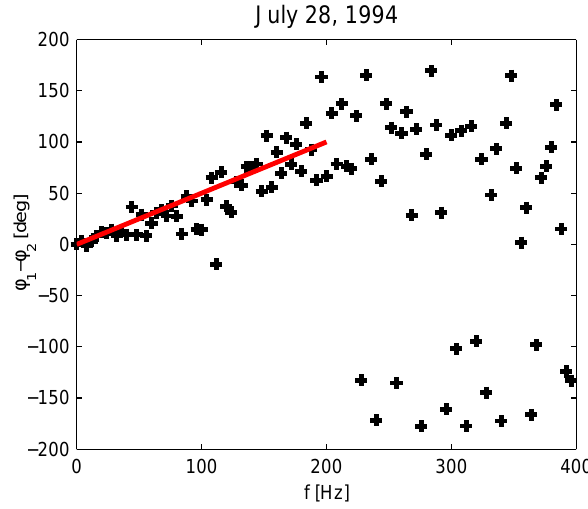
Fig.6. Phasedifferenceversusfrequencyfortwocrosscorrelateddensitysignals. Thephasedifferenceissmall Fig. 6. Phase difference versus frequency for two cross correlated in the zero frequency limit. For low frequencies (long wavelengths) there is a good fit to a straight line, and density signals. The phase difference is small in the zero frequency the estimated phase velocity is just the satellite velocity with respect to Earth. The linear fit is made for data limit. For low frequencies (long wavelengths) there is a good fit withacoherence above0.5. Hence,weconclude thatthedensityvariationsarespatialstructuresdowntoscale to a straight line, and the estimated phase velocity is just the satel- lengths ofafewiongyroradii ( ρ H + = 5–10 m, ρ O + = 20–40m). Dataistakenfromthesameinterval asthe lite velocity with respect to Earth. The linear fit is made for data datashowninFig. ?? . with a coherence above 0.5. Hence, we conclude that the density variations are spatial structures down to scale lengths of a few ion gyroradii ( ρ H + = 5–10m, ρ O + =20–40m). Data is taken from the same interval as the data shown in Fig.